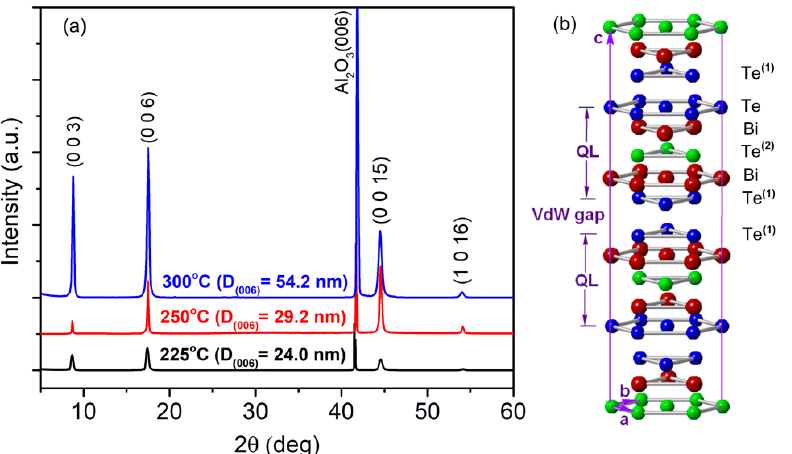
Figure 1. ( a ) XRD patterns of the Bi 2 Te 3 thin films deposited on the c -plane sapphire substrates at the various T S of 225 °C, 250 °C, and 300 °C, respectively. D (006) is the calculated grain size of the films using the Scherrer equation and Bi 2 Te 3 (006) peaks. ( b ) The schematics depicts the crystal structure of Bi 2 Te 3 .